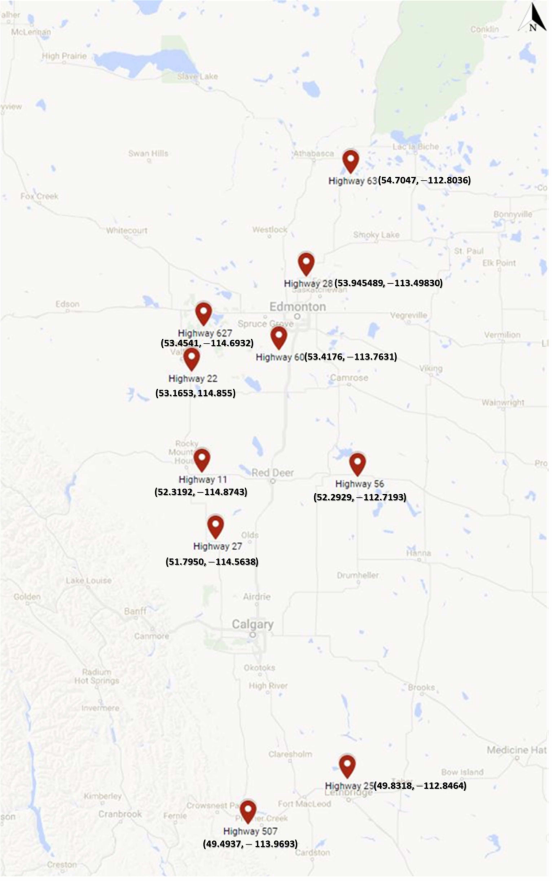
Figure 1. Map of highways assessed for fixed-object